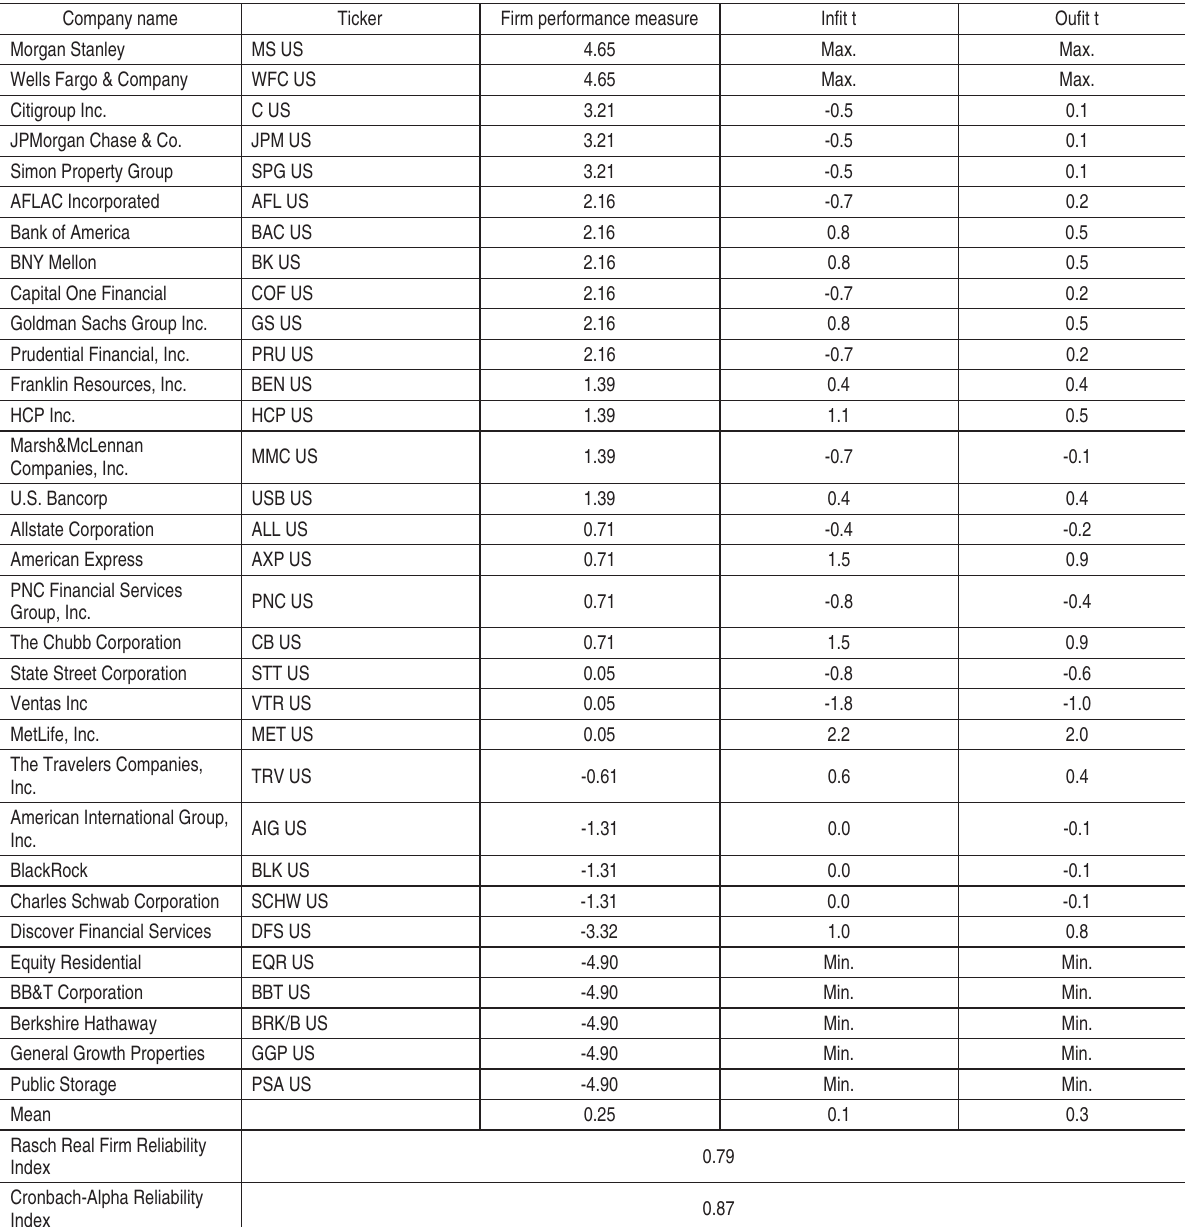
Table 3. “CDP” and capitalization should be consistent Climate Change Action Performance Ranking “CDP” sample of 32 U.S. financial firms